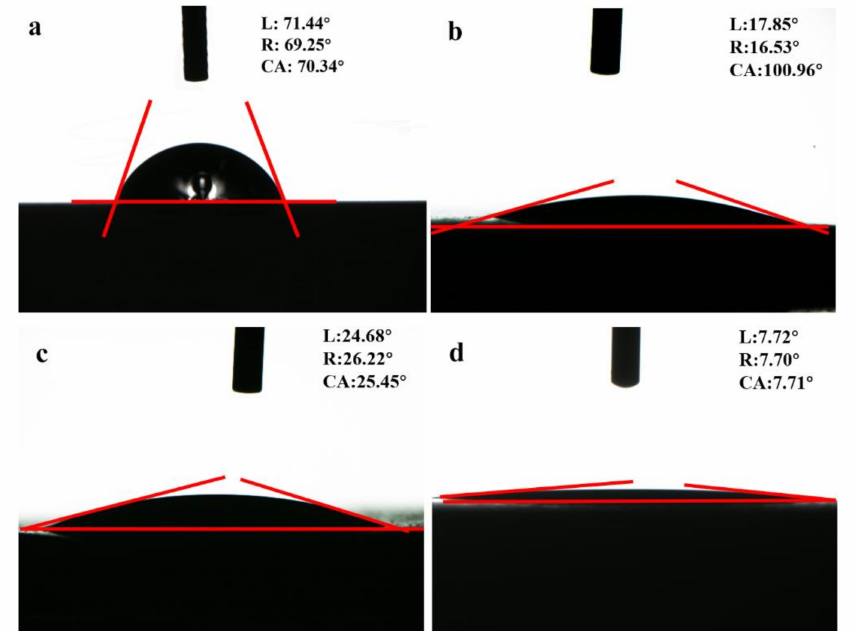
Figure 4. Contact angle measurement of Hank’s solution on the surface of samples, ZK60 ( a ), HA5 ( b ), HA7 ( c ), and HA9 ( d